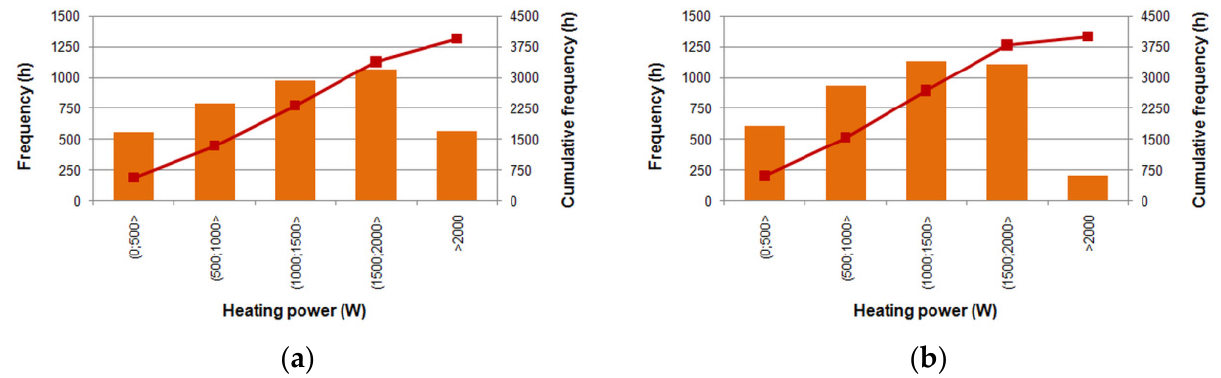
Figure 18. Histograms of heating power: ( a ) the base case; ( b ) method 1.